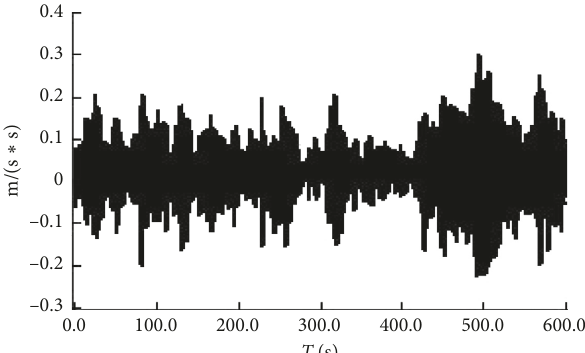
Figure 2: Vibration acceleration time-history curve at the top of No. 3 tower in working condition at wind speeds of